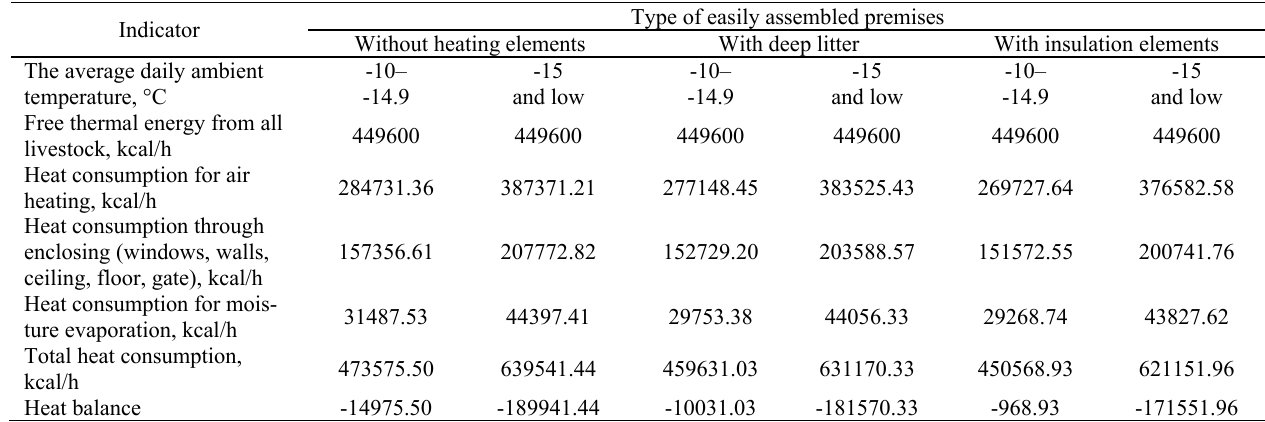
Heat balance in easily assembled premises of different types and sizes for 400 heads during the periods of low temperatures T ype of easily assembled Indicator